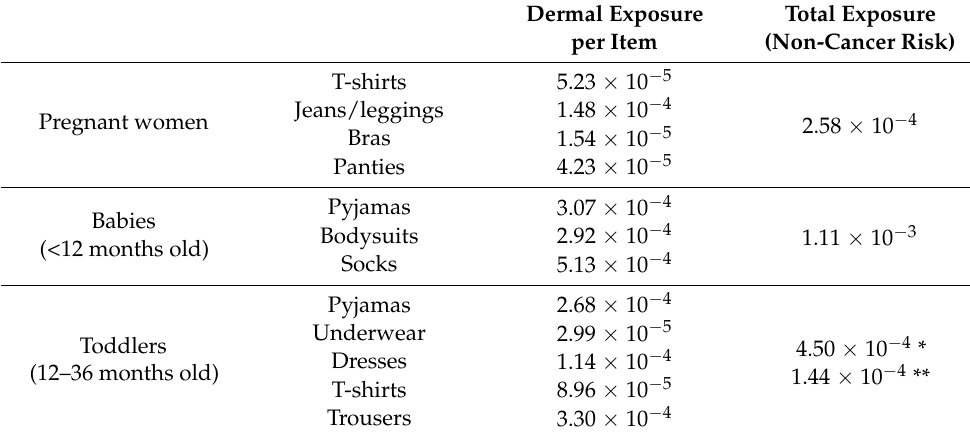
Table 4. Dermal exposure (mg/kg/day) to formaldehyde through clothing.